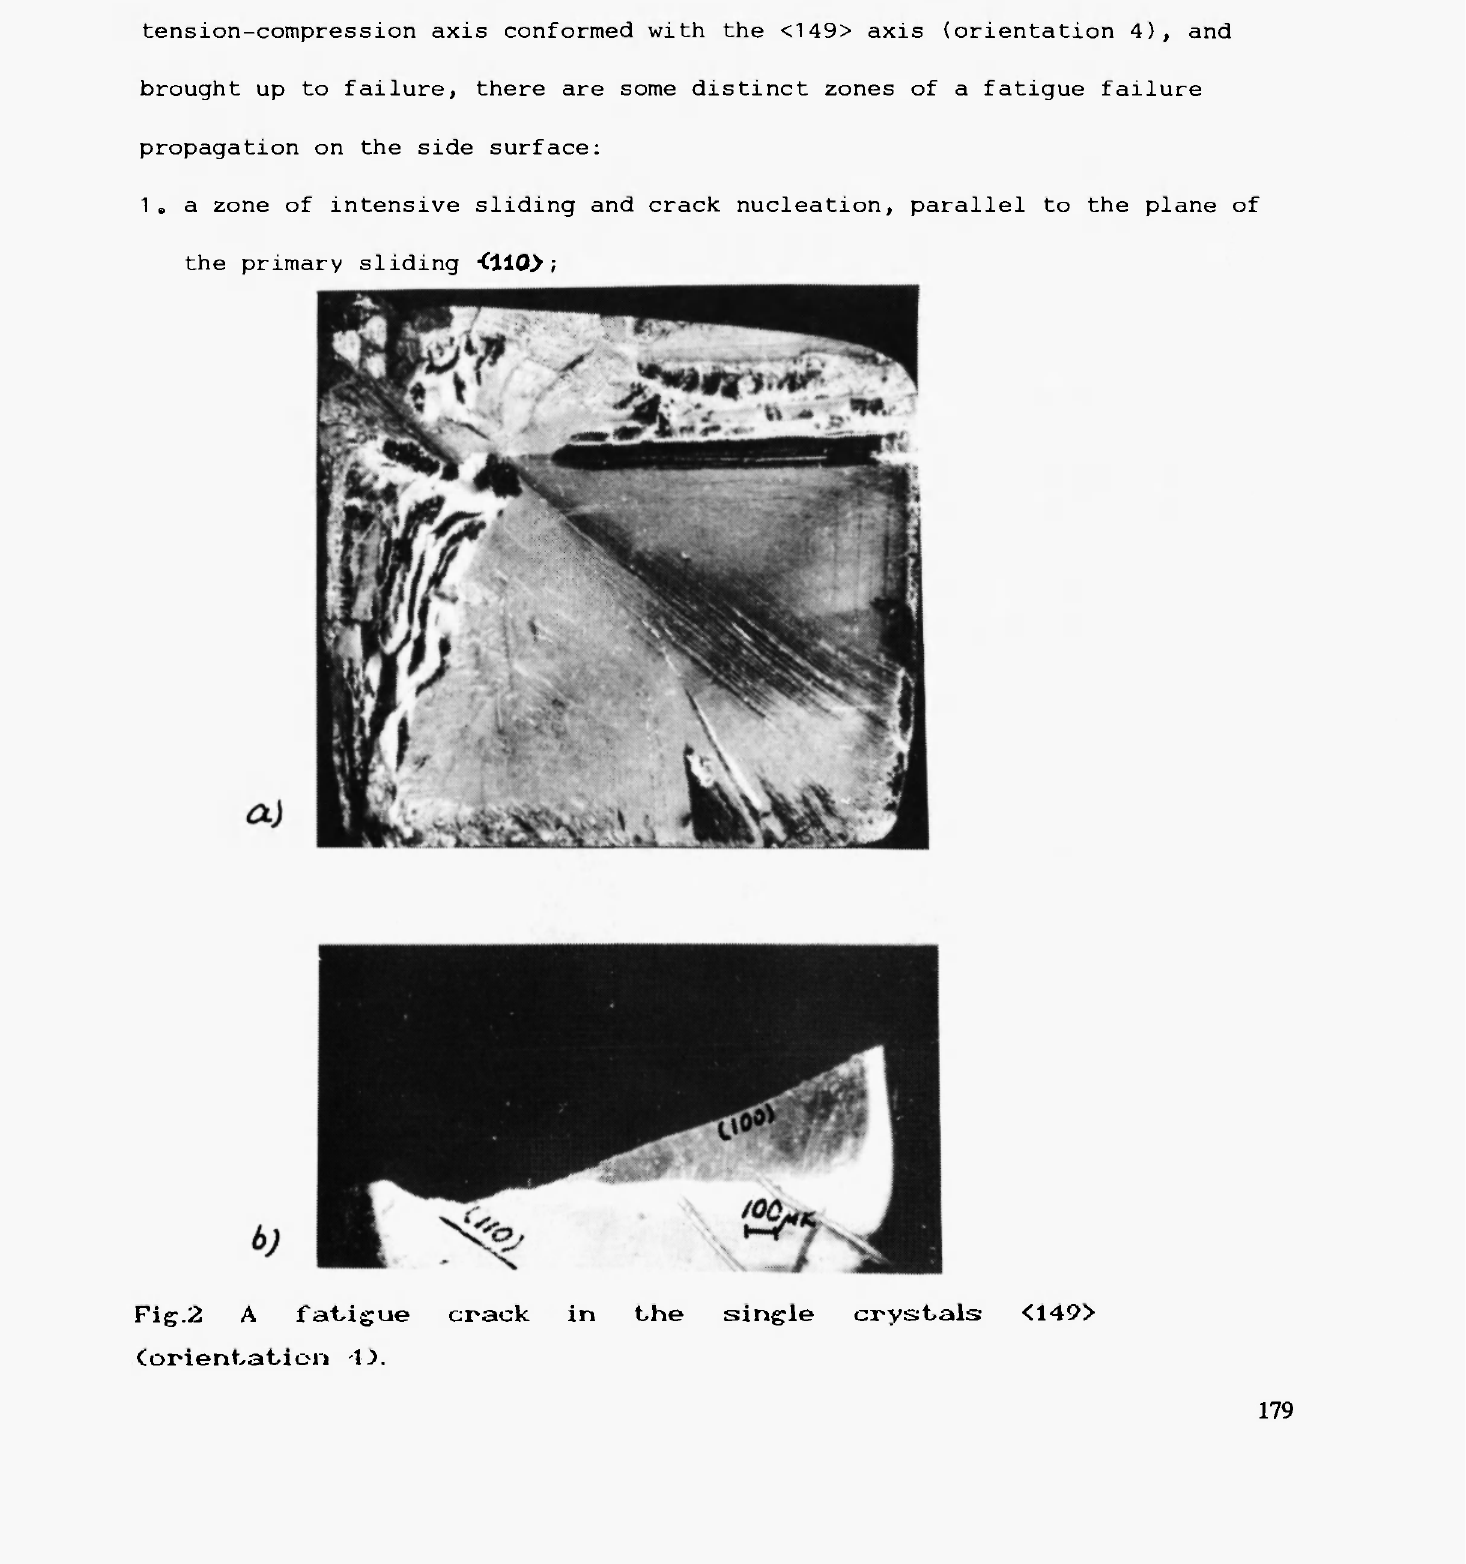
A fatigue crack in the single crystals <149>